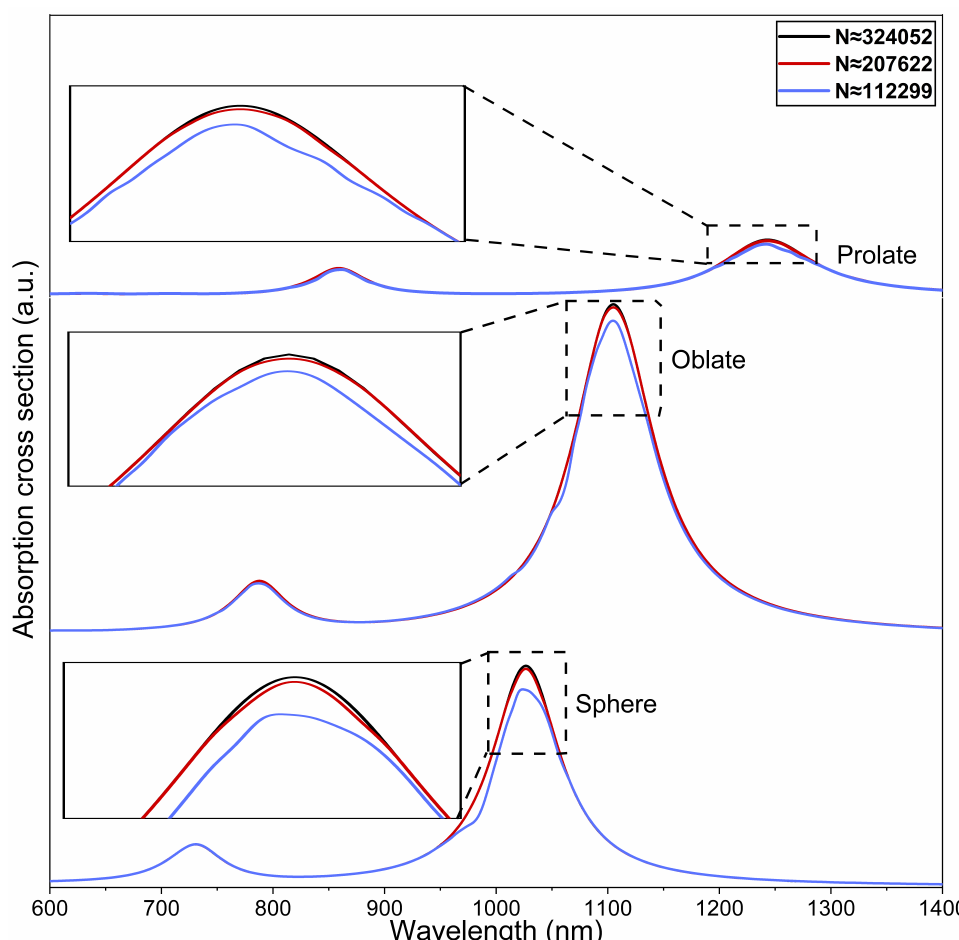
Figure 3. Mesh independence test: Absorption cross sections for the spherical ( r = 20 nm, t Au = 3 nm ) and non-spherical ( r eff = 23 nm, η = 3 ) core-shell nanostructures. The nanostructures are surrounded by water with a refractive index of 1.33. Here, N is the total number of mesh elements used in the present